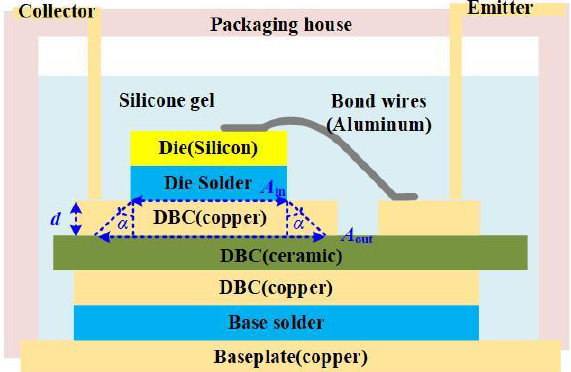
Figure 1. Structure of a wire-bonding Insulated Gate Bipolar Transistors (IGBT) module.